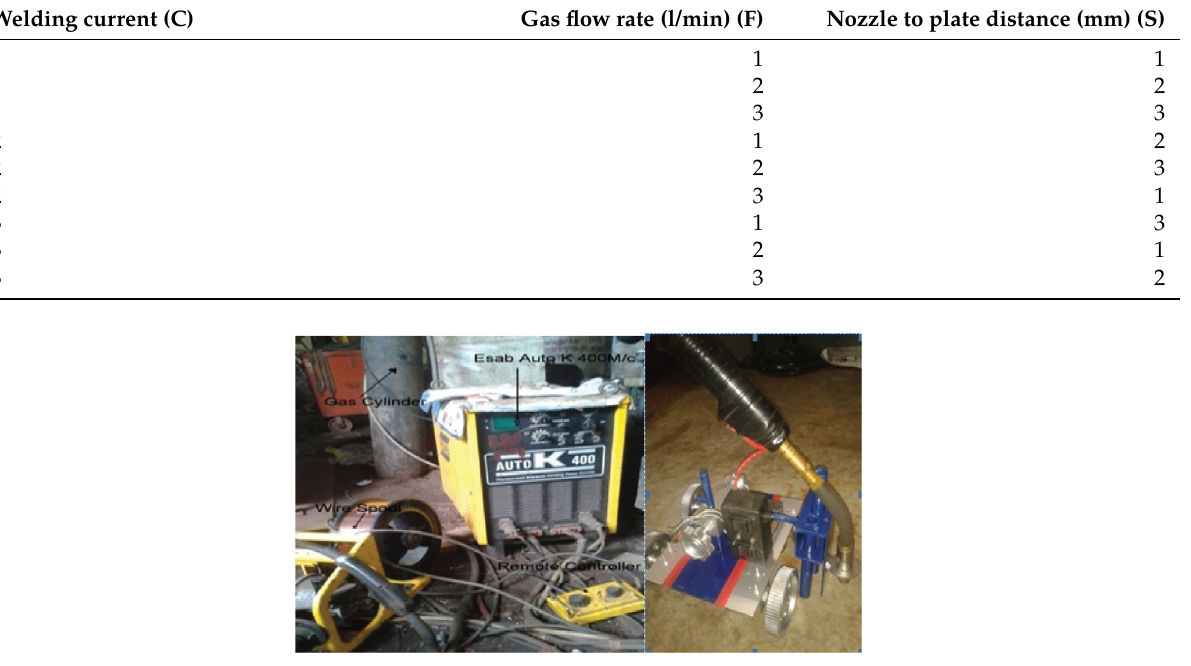
Figure 1: Photographic view of welding